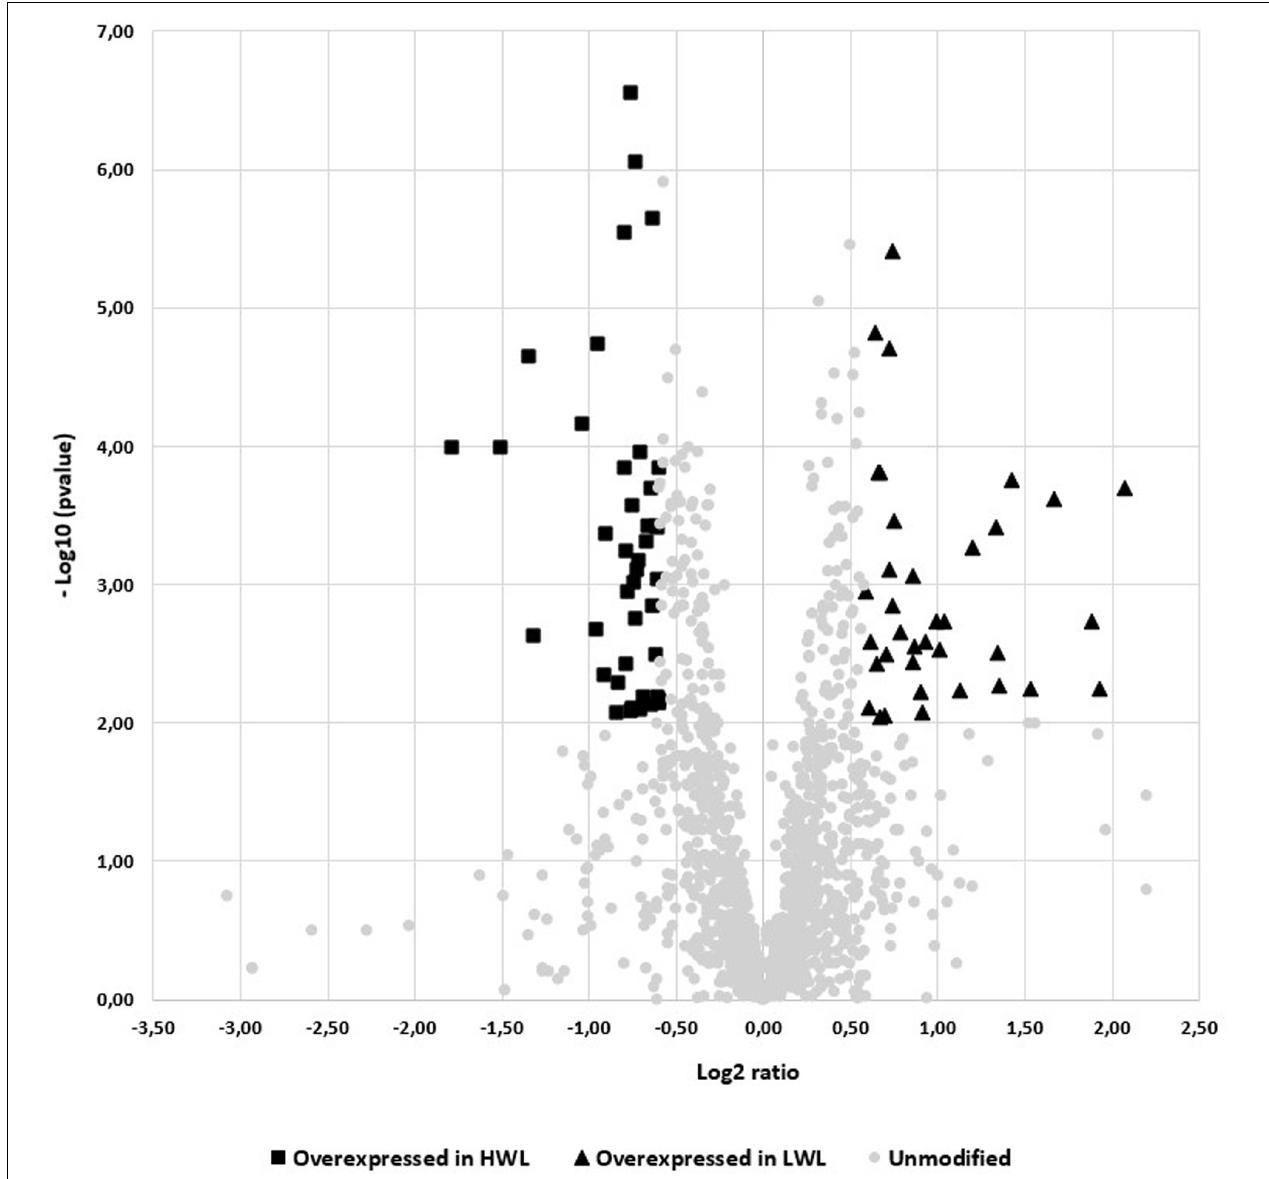
FIGURE 2 | Volcano-plot of the proteins expressed in the two studied groups ( n = 12/groups). Proteins with an unmodified level of expression were represented by circles, proteins overexpressed in the LWL group were represented by triangles and proteins overexpressed in the HWL group of livers were represented by